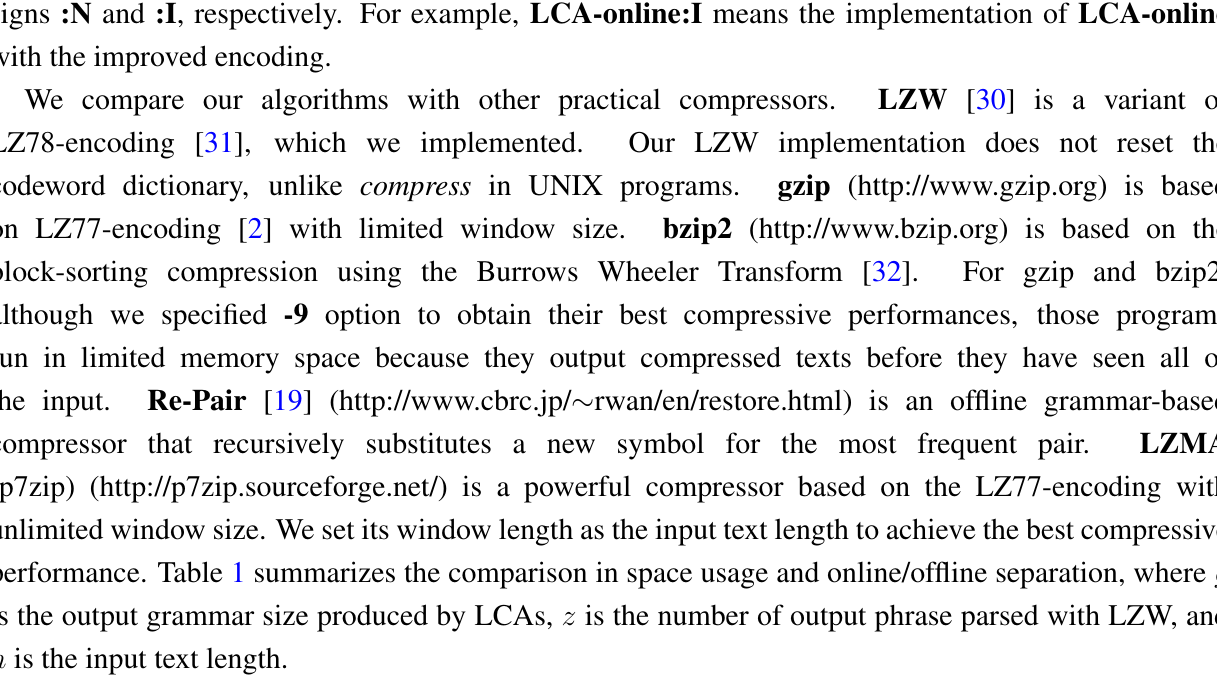
Table 1. Summary of comparison